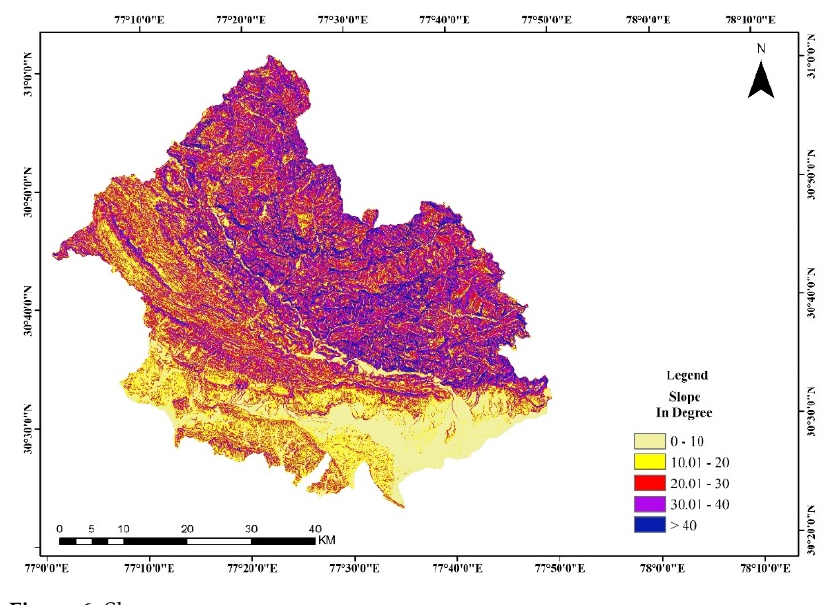
Figure 6. Slope map.